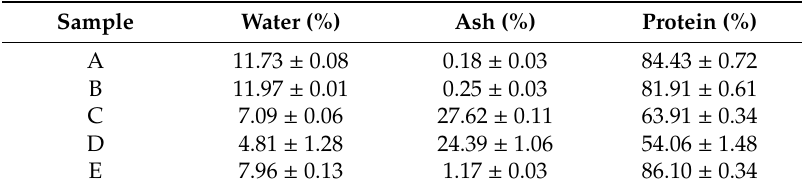
Table 2. Water, ash, and protein contents of commercial samples A and B from Sigma and Norland, respectively, and C, D, and E from di ff erent extraction